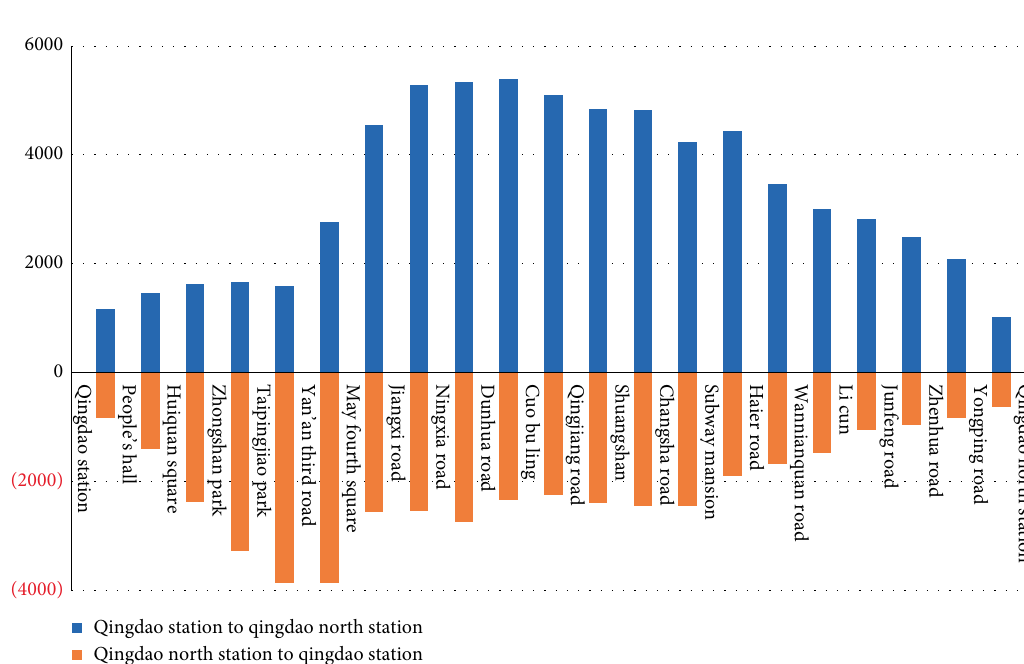
Figure 16: Average cross-sectional passenger flow of Metro line 3 in evening